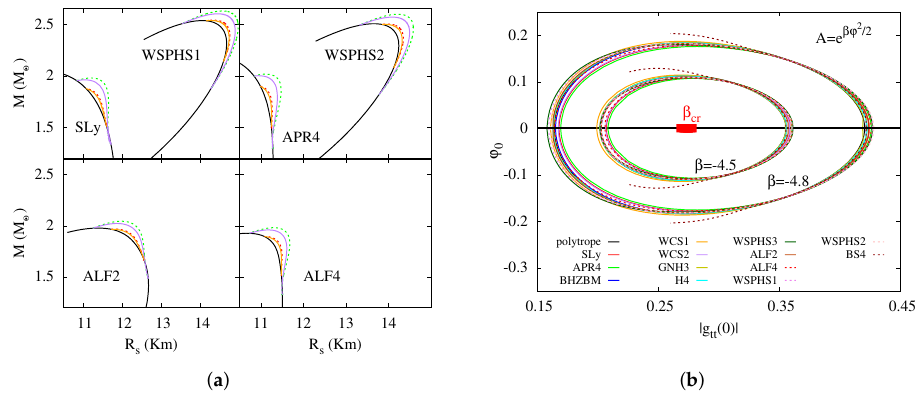
Figure 3. Spontaneous scalarization of neutron stars: ( a ) mass-radius relation for several equations of state for two values of β 0 , also shown is the GR relation; ( b ) universal relation for the value of the scalar field at the center ϕ ( 0 ) vs. the tt component of the metric at the center g tt ( 0 ) . β cr denotes the onset of scalarization